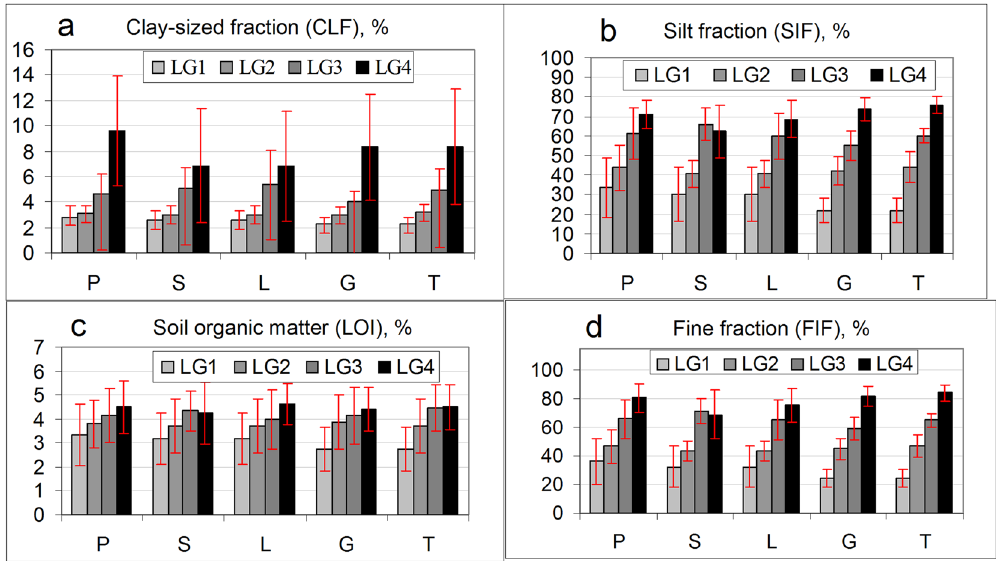
Figure 5: Increase in average percentages of in fl uential grain - size variables ( a, b and d ) and soil organic matter ( c ) in four LGs distinguished by fi ve site - classi fi cation approaches ( see Figure 3 ) . Error bars are based on standard